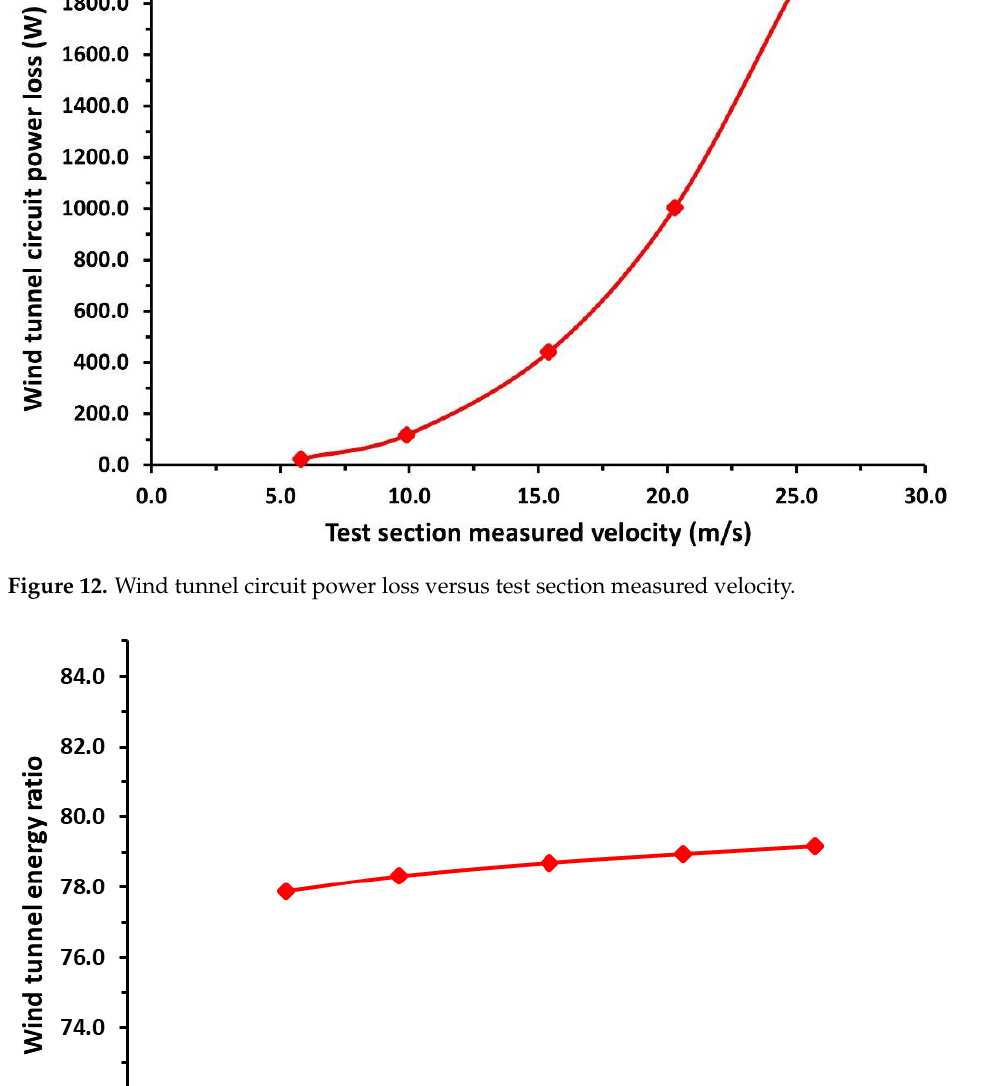
Figure 13. Wind tunnel energy ratio versus test section measured velocity.